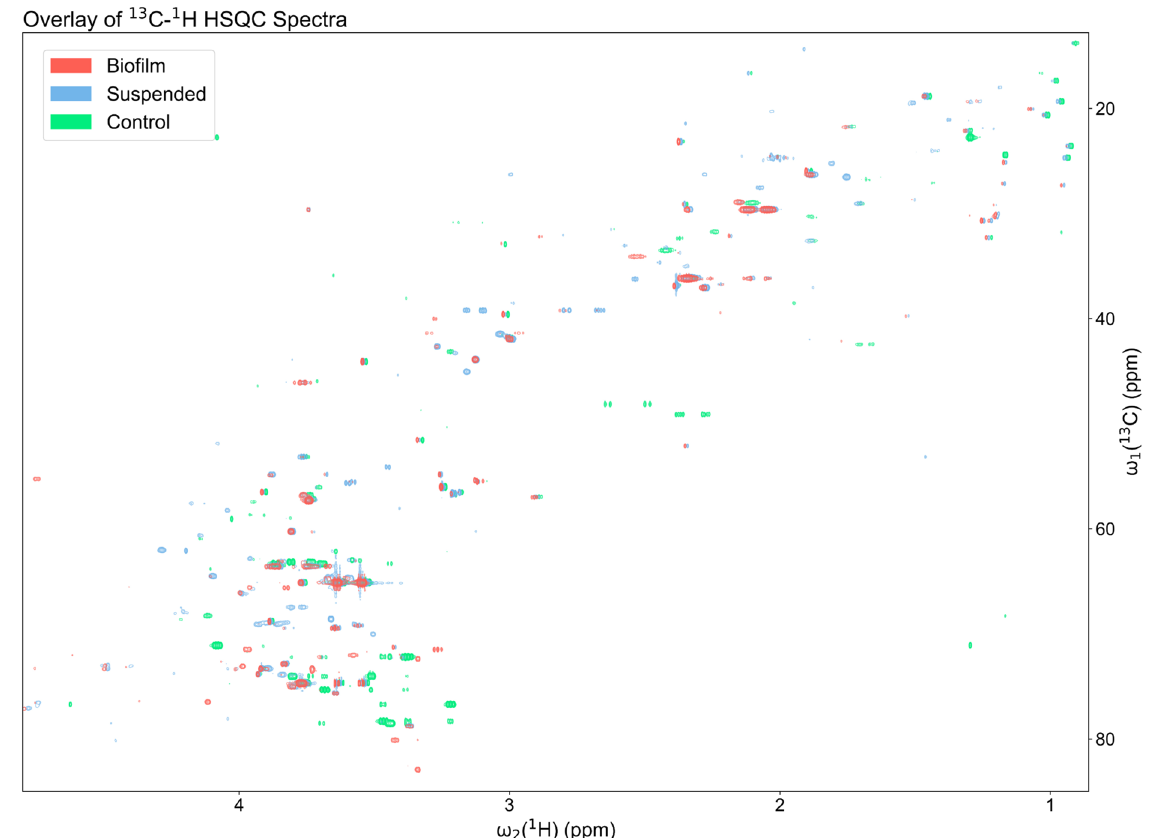
Figure 1. Overlay of a representative region of the 2D 13 C- 1 H HSQC spectra of a representative uninoculated BSF control (green; bottom), suspended culture (blue; middle), and biofilm (red; top) sample. Samples are all at 13 C natural abundance and each shifted 0.01 ppm down-field (left) for better visualization. Unique peaks were detected between each sample indicating metabolic differences between the BSF control and P. aeruginosa cultures grown in BSF as suspended culture and biofilm